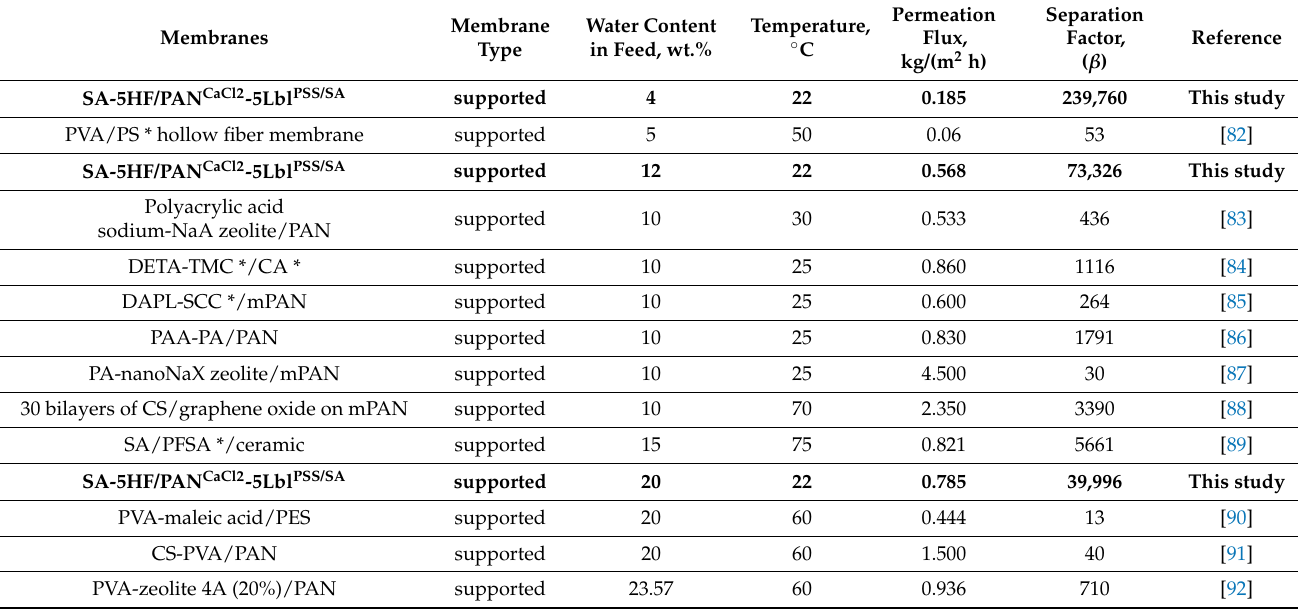
Table 8. Comparison of the transport properties of the membranes in the pervaporation dehydration of ethanol. Membranes